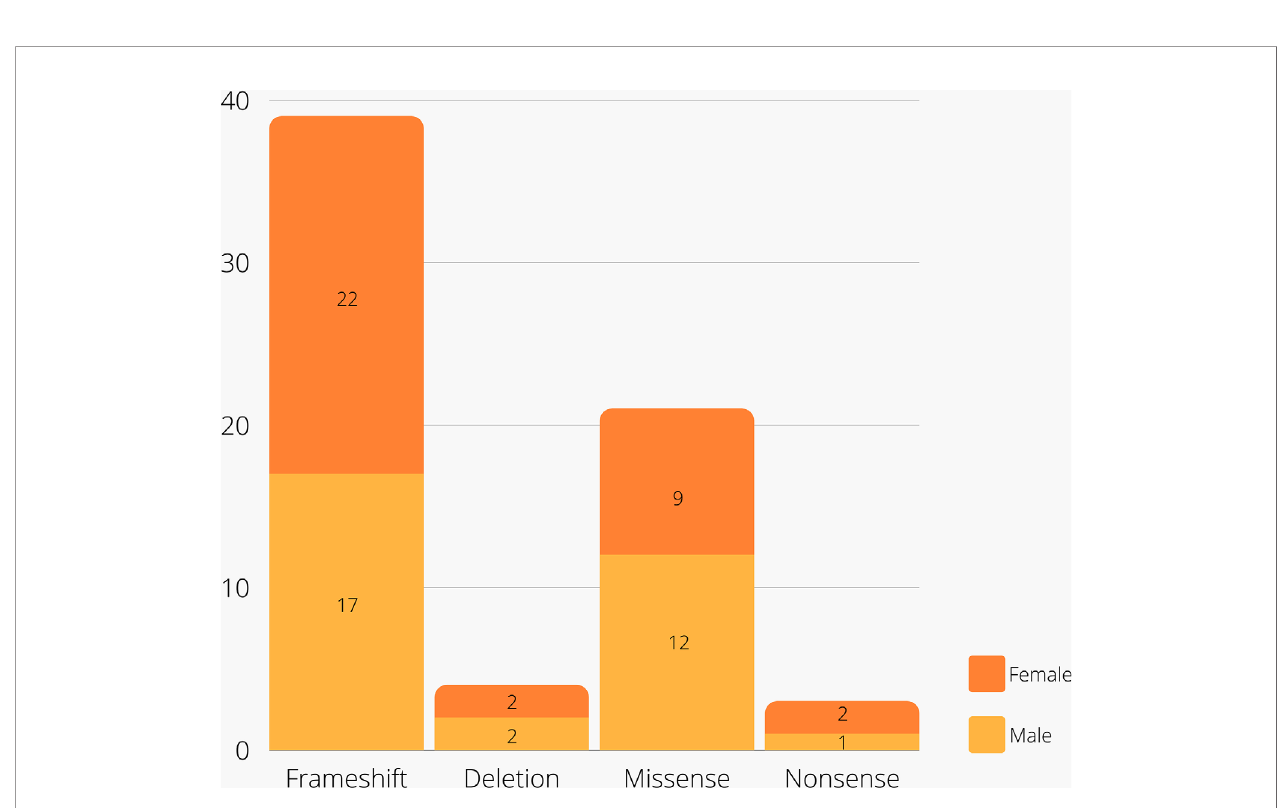
FIGURE 4 | Distribution of types of mutations and gender among